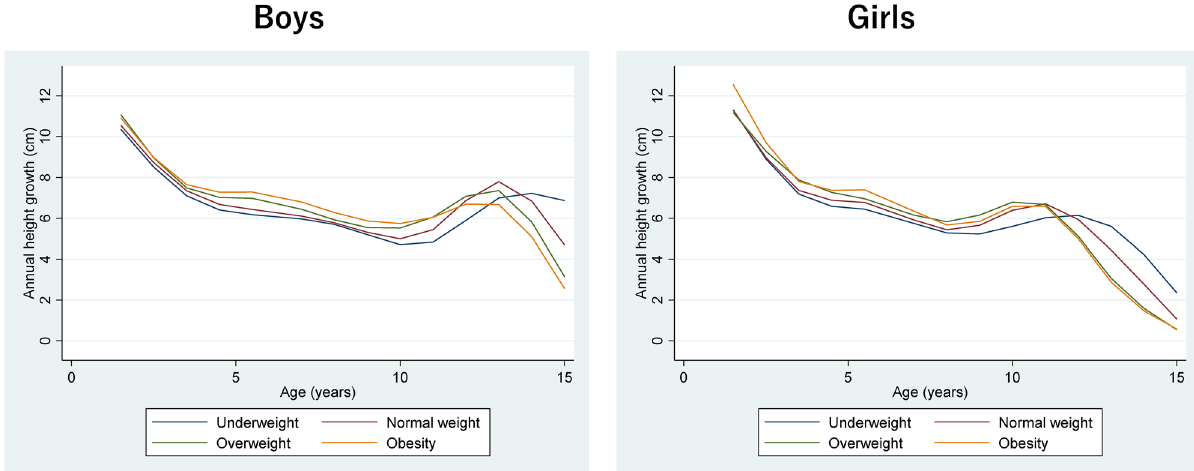
Figure 4. Dynamics of annual height growth (cm) through age 15